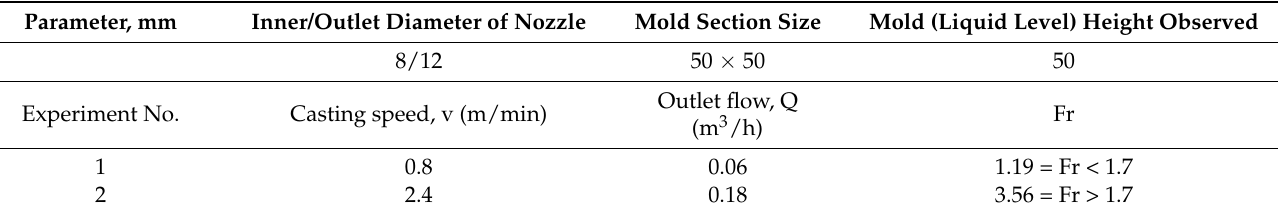
Table 1. Geometric parameters of mold and experimental condition.